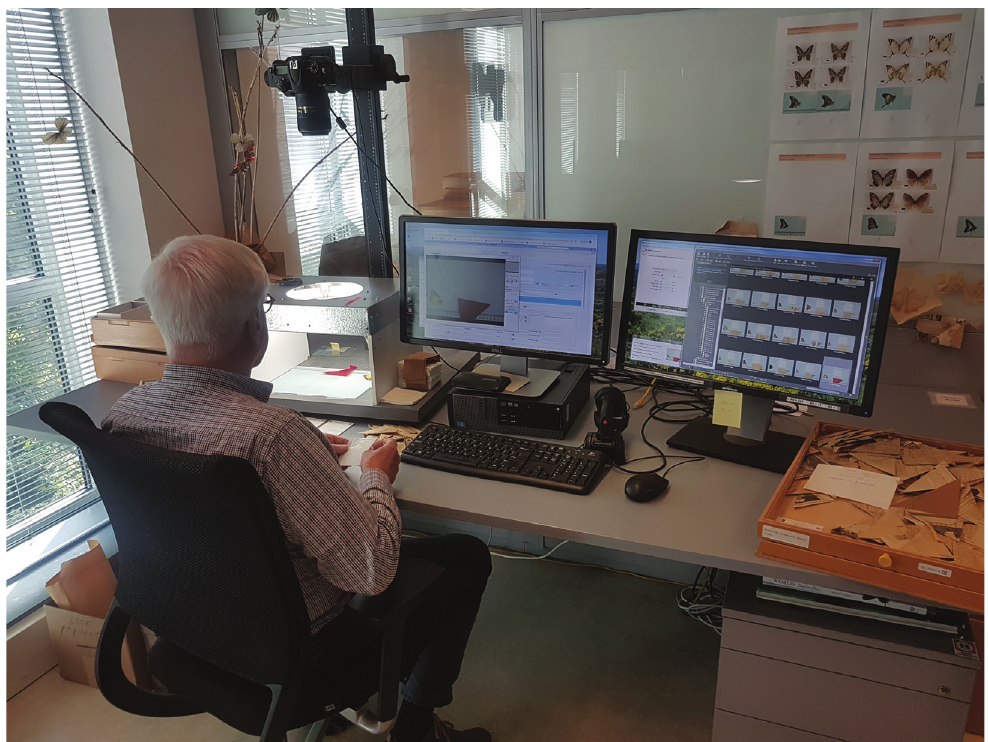
Figure 4. A work station which is occupied by volunteer Herman Hillebrand. On the right is the main stock of Lepidoptera and the computer screen on the left shows the live image of the camera. Photo by Luisa de